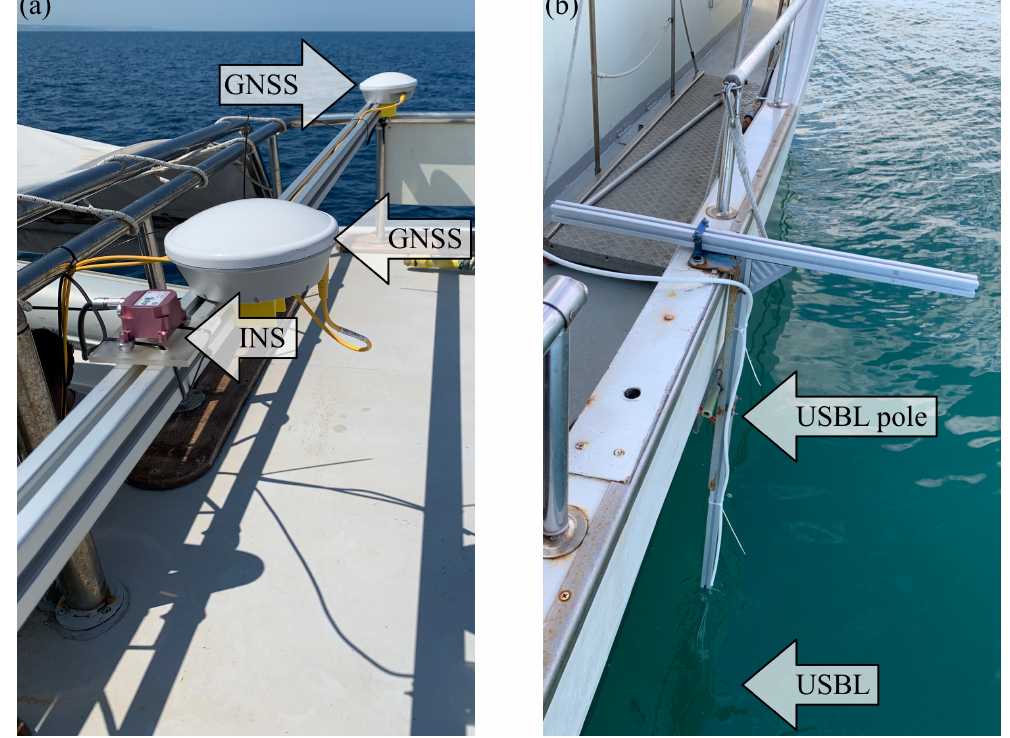
Figure 2. Setup for USBL positioning on surface vessel: ( a ) GNSS antennas and INS platform. ( b ) Structure for USBL.